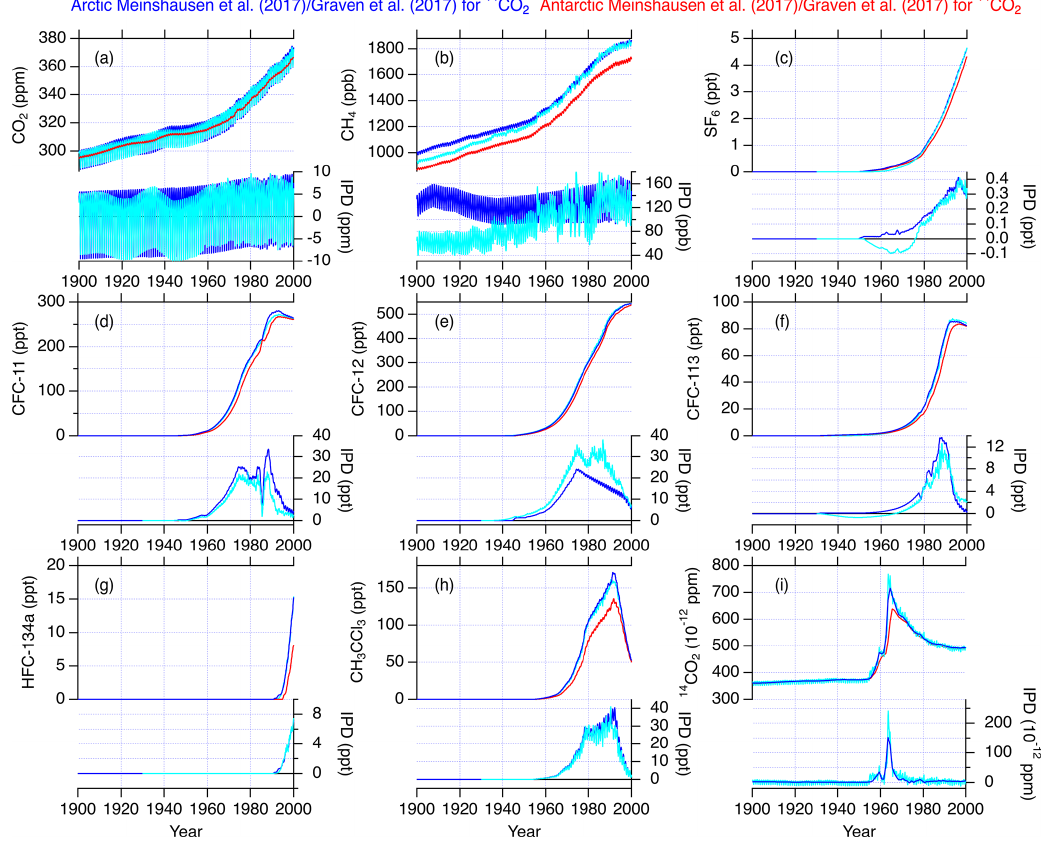
Figure 2. Atmospheric scenarios of various trace gases used in this study. The Arctic histories prepared for the NEEM firn air modelling (Buizert et al., 2012) are in light blue. The Arctic and Antarctic histories for CMIP6 (Meinshausen et al., 2017) are in blue and red, respec- tively. For 14 CO 2 , the CMIP6 historical data are from Graven et al. (2017). The interpolar differences (IPDs) calculated from the Arctic histories with respect to the Antarctic CMIP6 histories are also shown (right